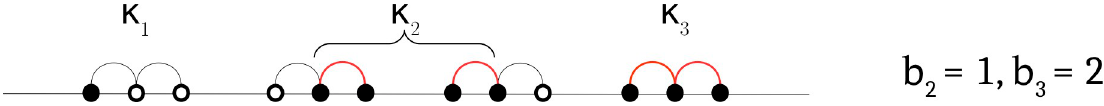
Fig 4. An epistatic network made of double arches used for simulation and analytic derivation. Numbers k i denote the numbers of clusters with i connected sites in a genome. Dots show deleterious alleles. Interactions between the existing deleterious alelles are shown in